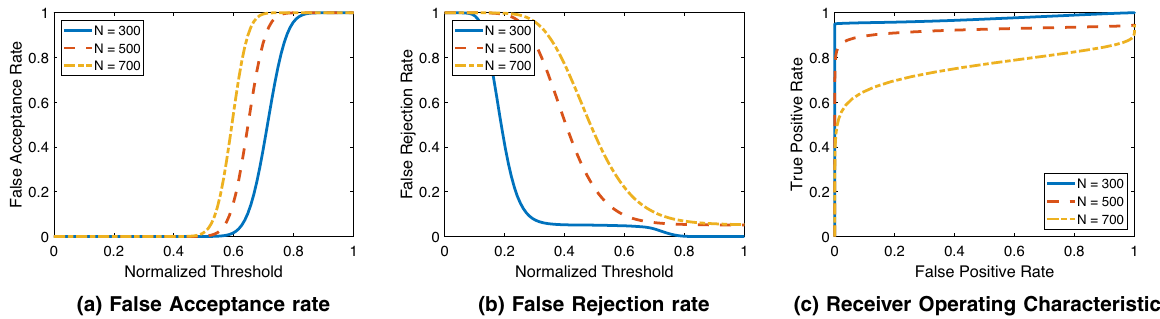
Fig. 4 Performance evaluation of the proposed autoencoder